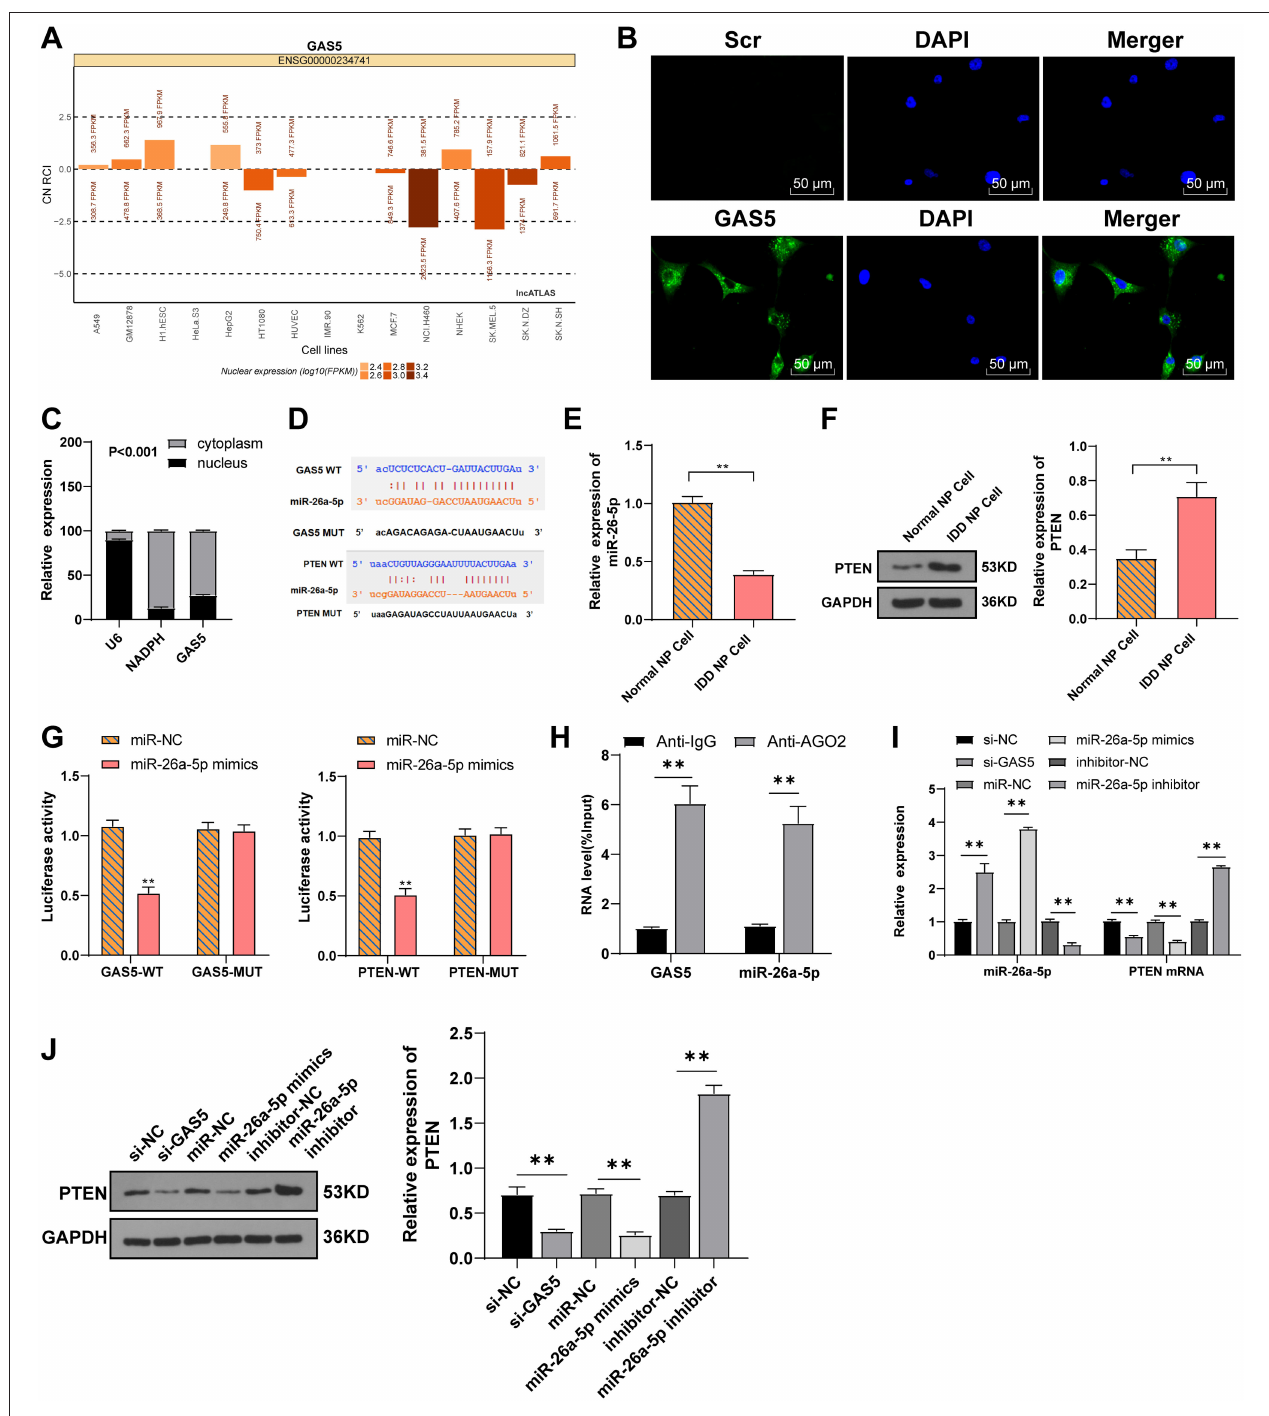
FIGURE 3 | LncRNA GAS5 and PTEN competitively bind to miR-26a-5p. (A) LncATLAS predicted that lncRNA GAS5 was mostly located in the cytoplasm. (B) FISH assay and (C) nuclear-cytoplasmic RNA separation confirmed the distribution of lncRNA GAS5 in degenerative NPCs. (D) Starbase and TargetScan predicted the binding sites between lncRNA GAS5 and miR-26a-5p, and miR-26a-5p and PTEN. (E) RT-qPCR was used to detect miR-26a-5p expression. (F) Western blot was used to detect PTEN expression. (G) Dual-luciferase assay confirmed the binding relation between lncRNA GAS5 and miR-26a-5p, and miR-26a-5p, and PTEN. (H) RIP test verified the interaction between lncRNA GAS5 and miR-26a-5p. (I) RT-qPCR was used to detect the miR-26a-5p expression and PTEN mRNA expression in degenerative NPCs. (J) Western blot was used to detect PTEN expression in degenerative NPCs. The cell experiment was repeated three times, and the data were expressed as mean ± standard deviation; independent t -test was used for comparison between two groups in (E–H) , while one-way ANOVA was used for comparison among multiple groups in (I,J) , followed by Tukey’s multiple comparisons test. ** p < 0.01.